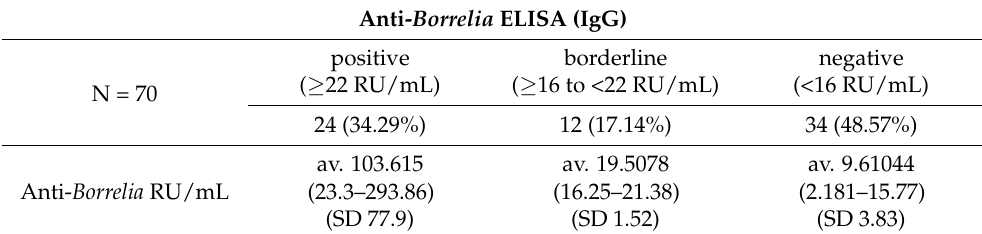
Table 2. Laboratory findings of Anti- Borrelia IgG levels with interpretation provided in the kit (Euroimmun,